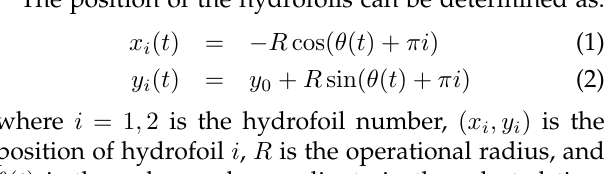
Fig. 1. The detailed diagram of the cyclorotor with two hydrofoils: θ - polar coordinates of the hydrofoils, V W - wave induced fluid velocity, V R - speed of the foils, V HM - instantaneous radiation from the moving foil and V HW - the wake which is left behind, ˆ V - the overall relative to hydrofoil fluid velocity, α - the attack angle, F L ,F D ,F T - lift, drag and tangential